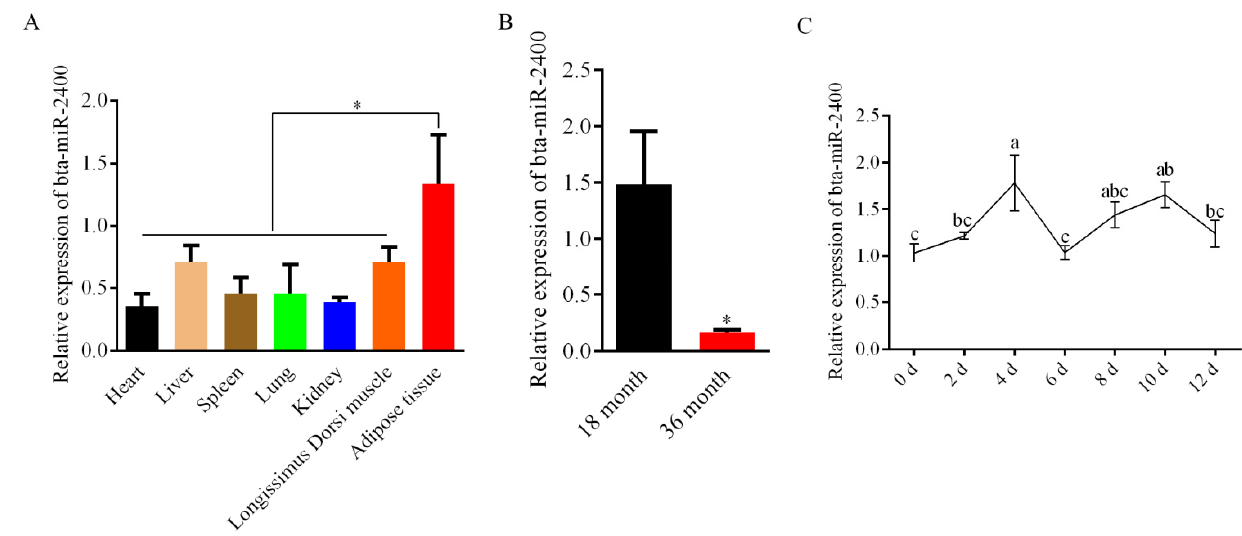
Figure 1. Expression profiles of bta-miR-2400 in tissues and adipocytes. ( A ) The bta-miR-2400 expression in different yak tissues and ( B ) different adipose tissue stages. ( C ) The expression pattern of bta-miR-2400 during yak preadipocyte differentiation. * p < 0.05. Duncan’s Multiple Range Test was used for multiple comparisons, different lowercase letters represent significant differences ( p < 0.05).